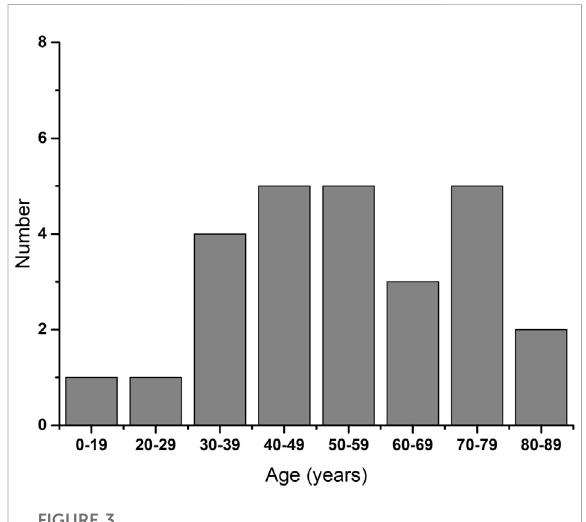
FIGURE 3 DistributionofageatthetimeofdiagnosisofHZObydecade.